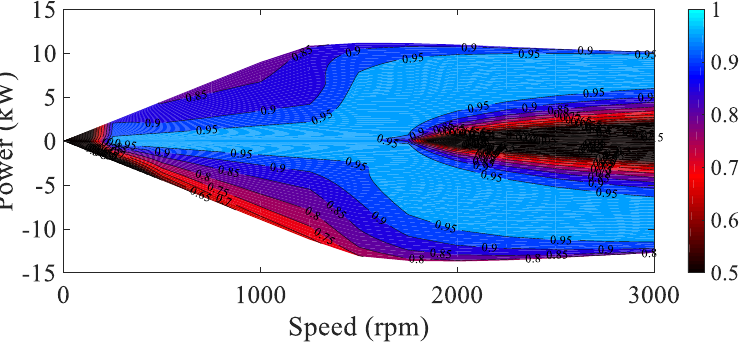
Figure 21. Power factor map of the Model-III.